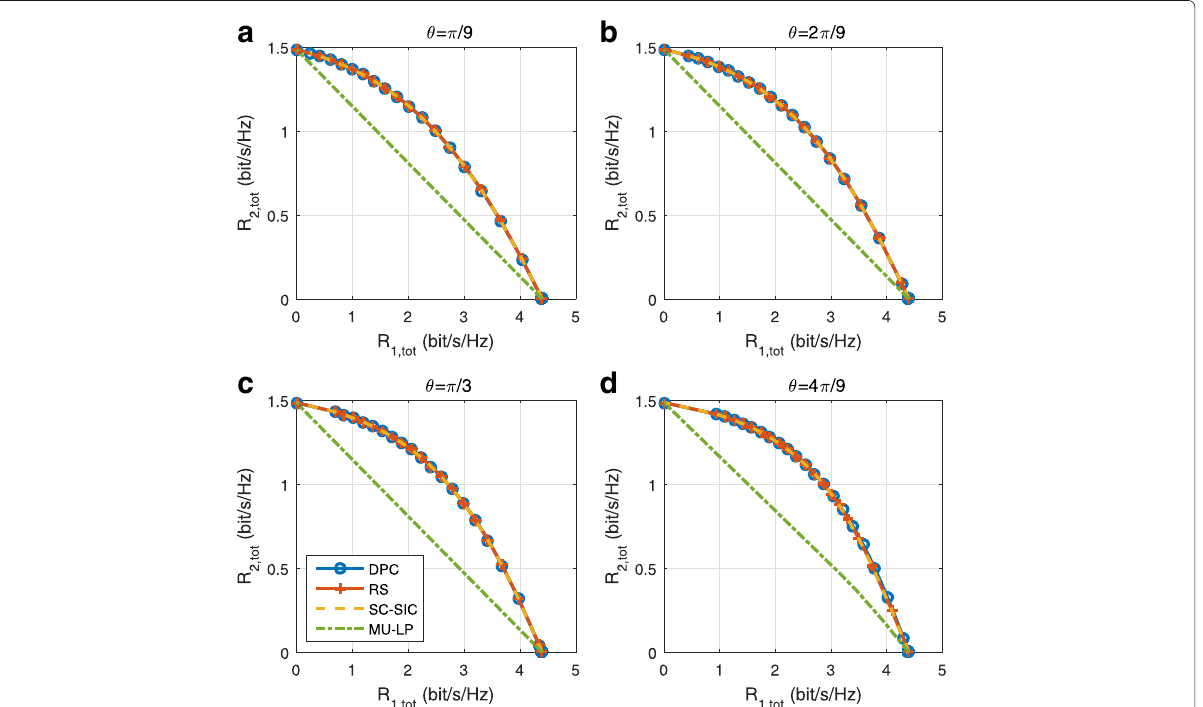
Fig. 25 Achievable rate region comparison of different strategies in perfect CSIT, γ = 0.3, N t = 2, SNR = 10 dB. a θ = π/ 9. b θ = 2 π/ 9. c θ = π/ 3.